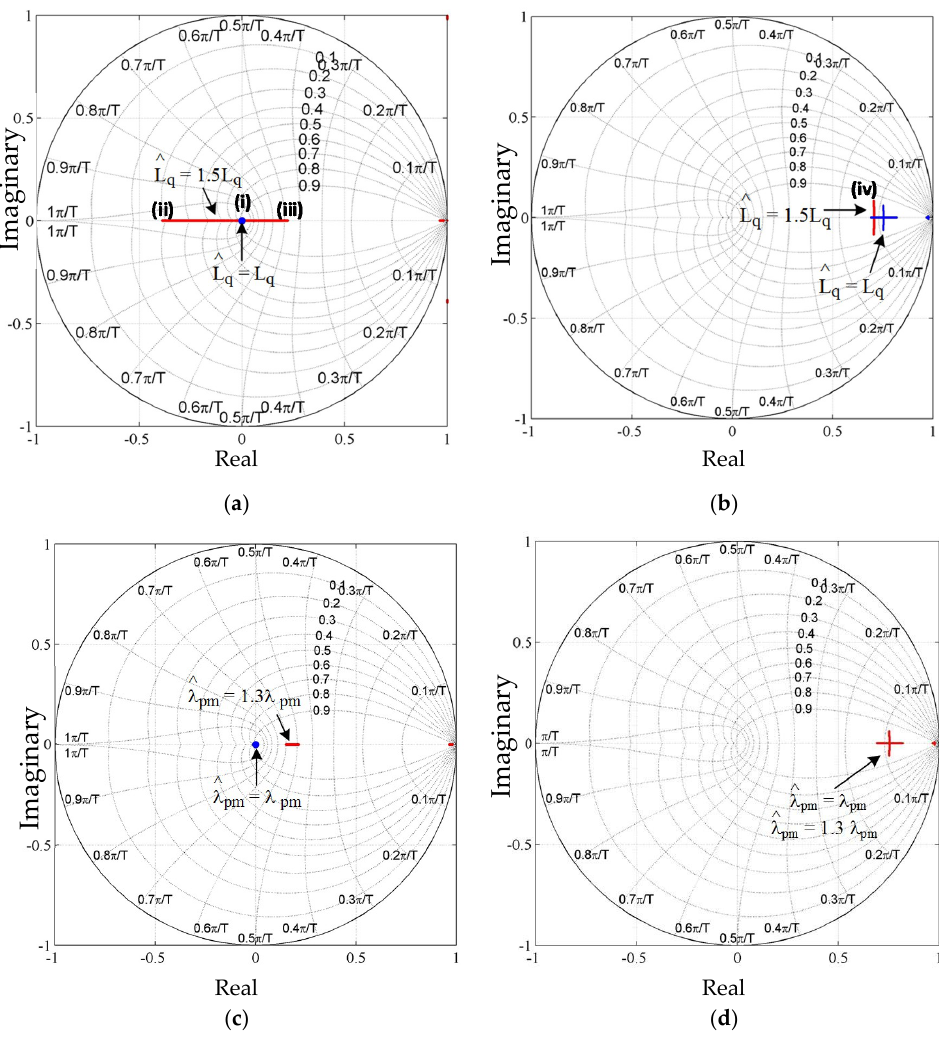
Figure 9. Eigenvalue (EV) migration of DB-DTFC and CVC along the U.S.06 driving cycle when ˆ L q and ˆ λ pm are detuned by 50% and 30%, respectively. ( a ) When L q is detuned in DB-DTFC; ( b ) When L q is detuned in CVC; ( c ) When λ pm is detuned in DB-DTFC; ( d ) When λ pm is detuned in CVC. Energies 2017 , 10 , x